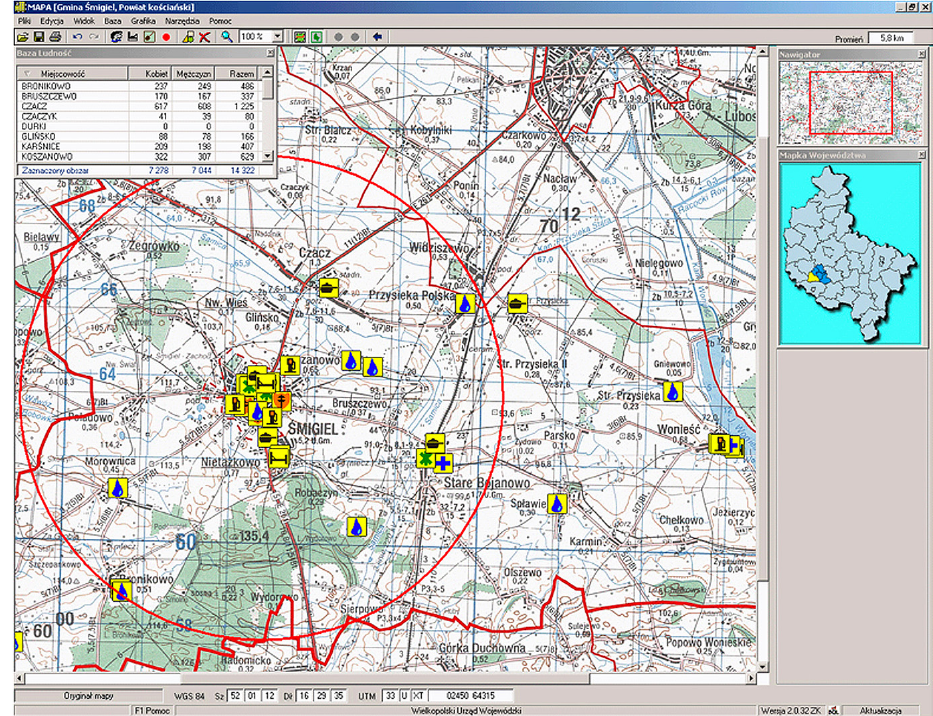
Figure 7. ARCUS 2005 system (Chory´nski, 2013). The map displays selected resources of the municipality marked with the flag, in this case the municipality of Smiegiel in the Wielkopolska (Greater Poland) region in Poland. This involves elements such as infrastructure, hospitals, pharmacies, volunteer fire brigade stations, petrol stations, accommodation, clinics and primary health care,